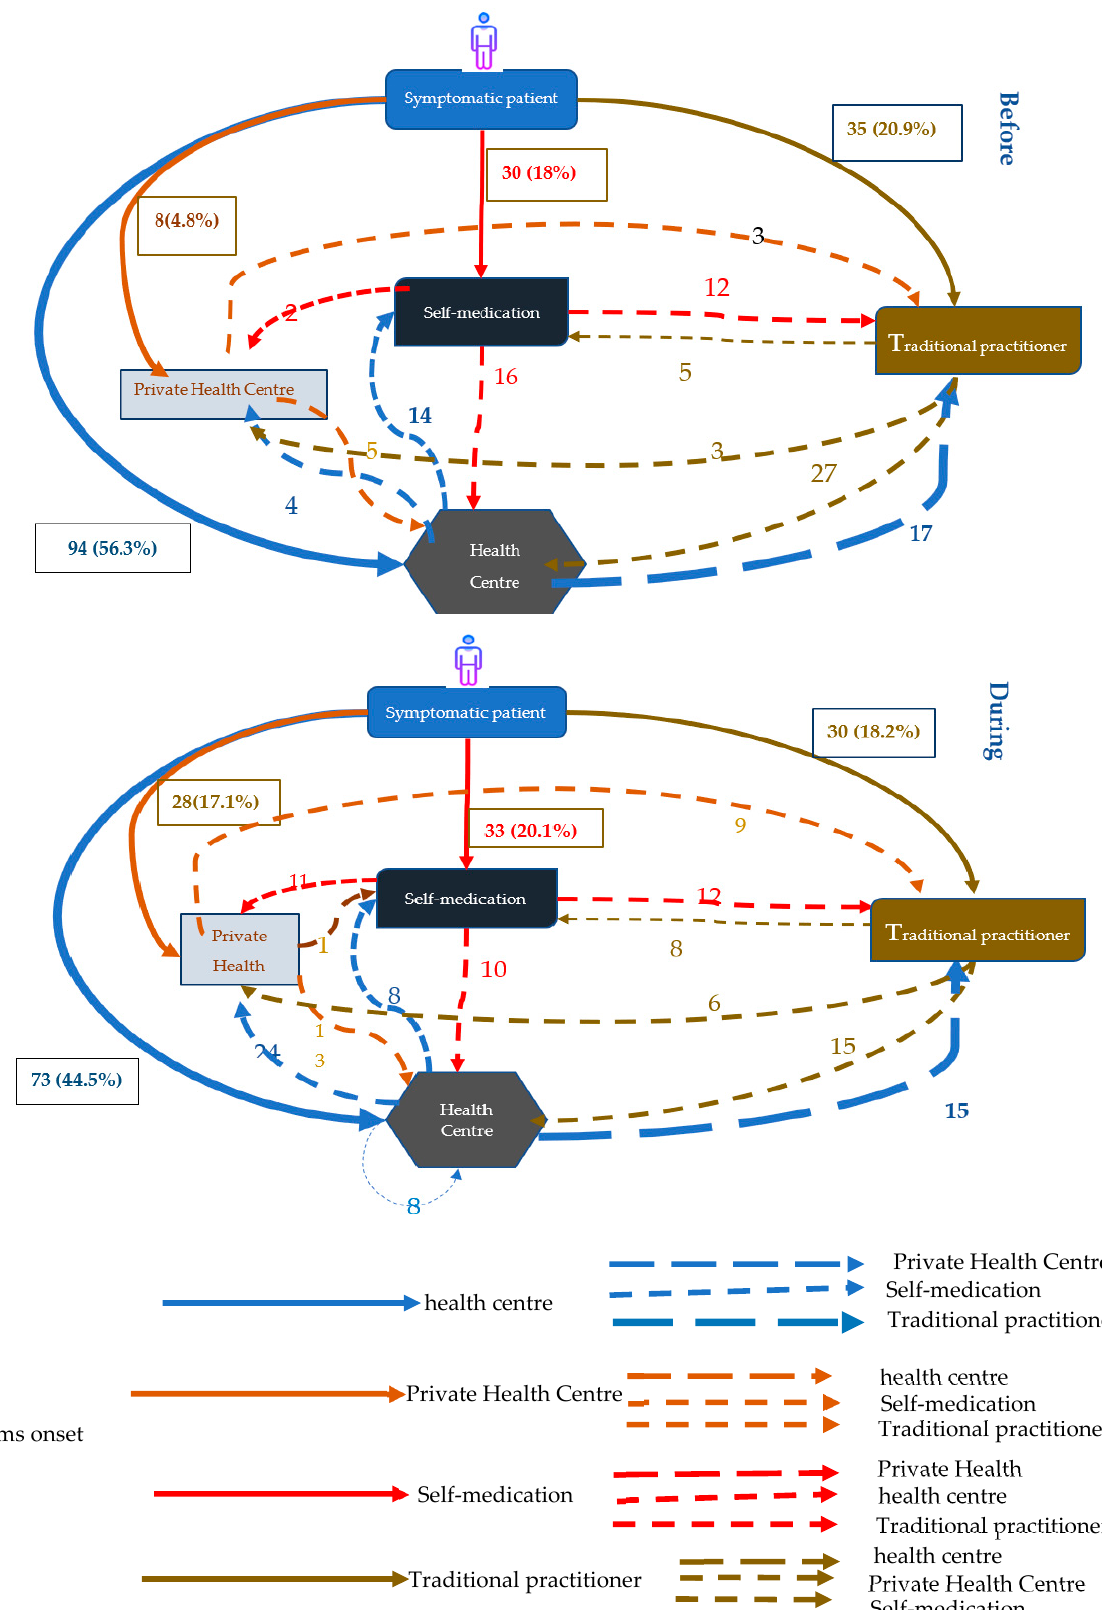
Figure 1. Therapeutic itinerary of patients Before and During COVID-19.